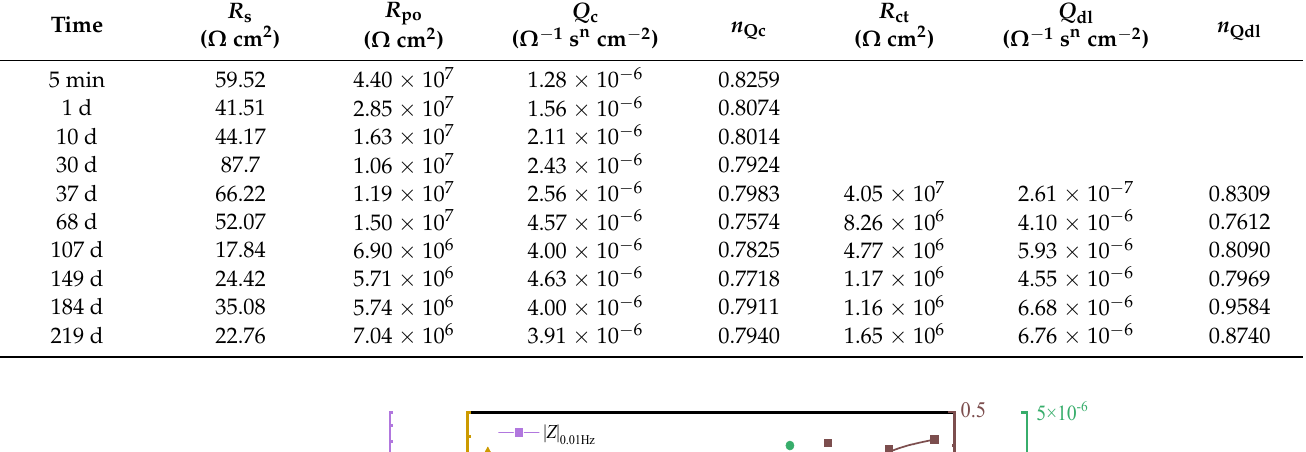
Table 5. The impedance fitting parameters of the T700/BMI composite.